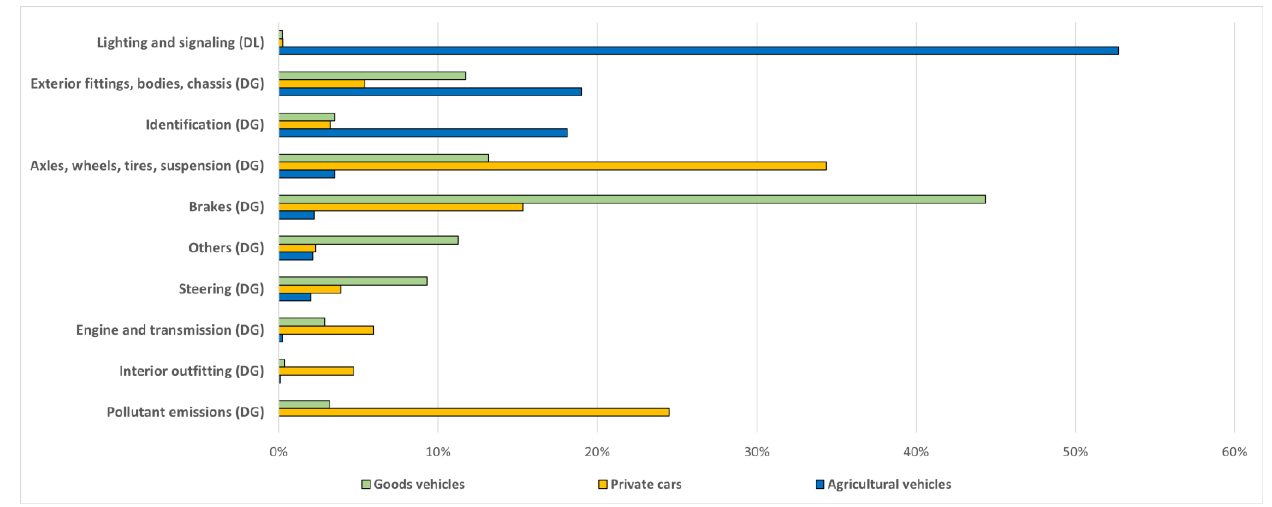
Figure 4. Comparison of serious defects with other types of vehicles.